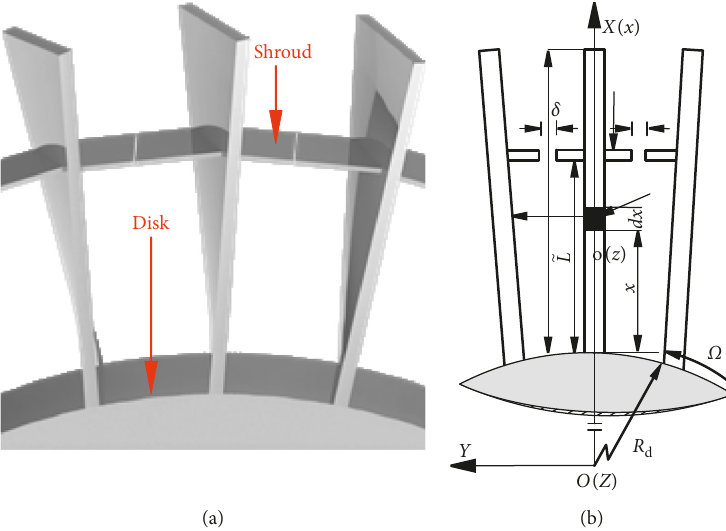
Figure 1: (a) The model diagram of shrouded blades. (b) Schematic diagram of rotating shrouded blades in a constant